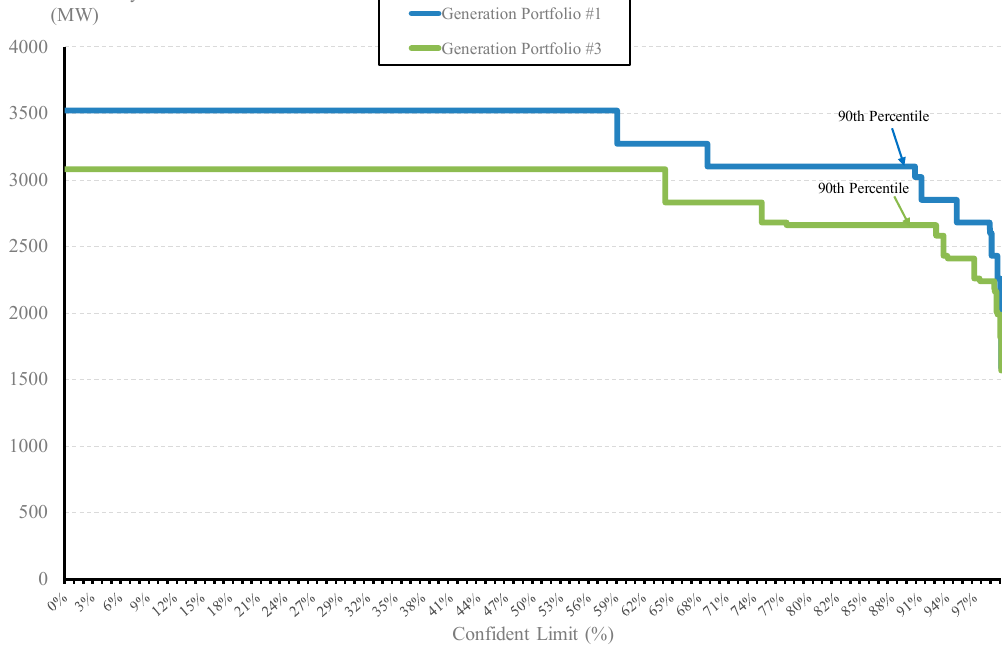
Figure 4. Primary supply of hedge contracts at 0% renewable market share.